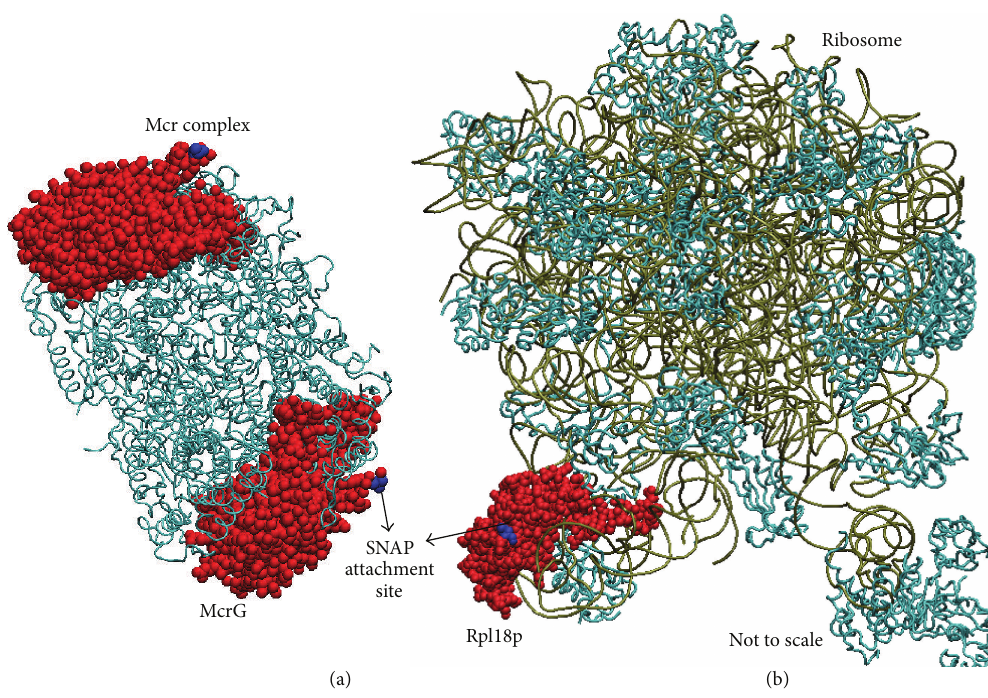
Figure 2: (a) The Mcr complex from M. barkeri (1E6Y [58]) with the McrG subunit shown in red with the SNAP attachment site shown in blue. (b) The large subunit of an archaeal ribosome ( Haloarcula marismortui , 4HUB) showing the L18p subunit in red and the C-terminus where the SNAP is attached in blue. These suggest that the position of SNAP is on the outer part of the complexes, which enables capture by the SNAP antibody.